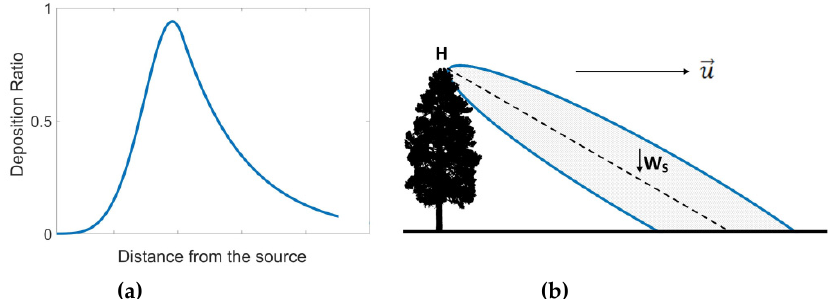
Figure 3. Gaussian tilted plume model: ( a ) cross-wind integrated pollen deposition at the ground; ( b ) schematic of pollen deposition at the ground. The parameters are: distance from the pollen source, height of pollen release ( H ), pollen settling velocity ( W s), and wind mean speed (cid:1873)(cid:4652)(cid:1318) ). Adapted from [64].